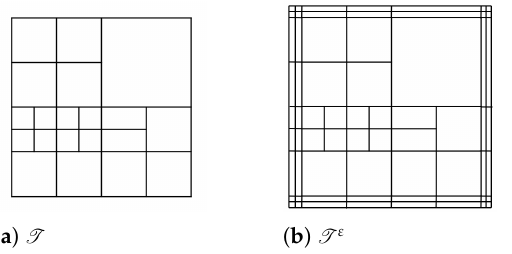
Figure 3. A T-mesh T and its extended T-mesh T ε associated with S ( 2,2,1,1, T )